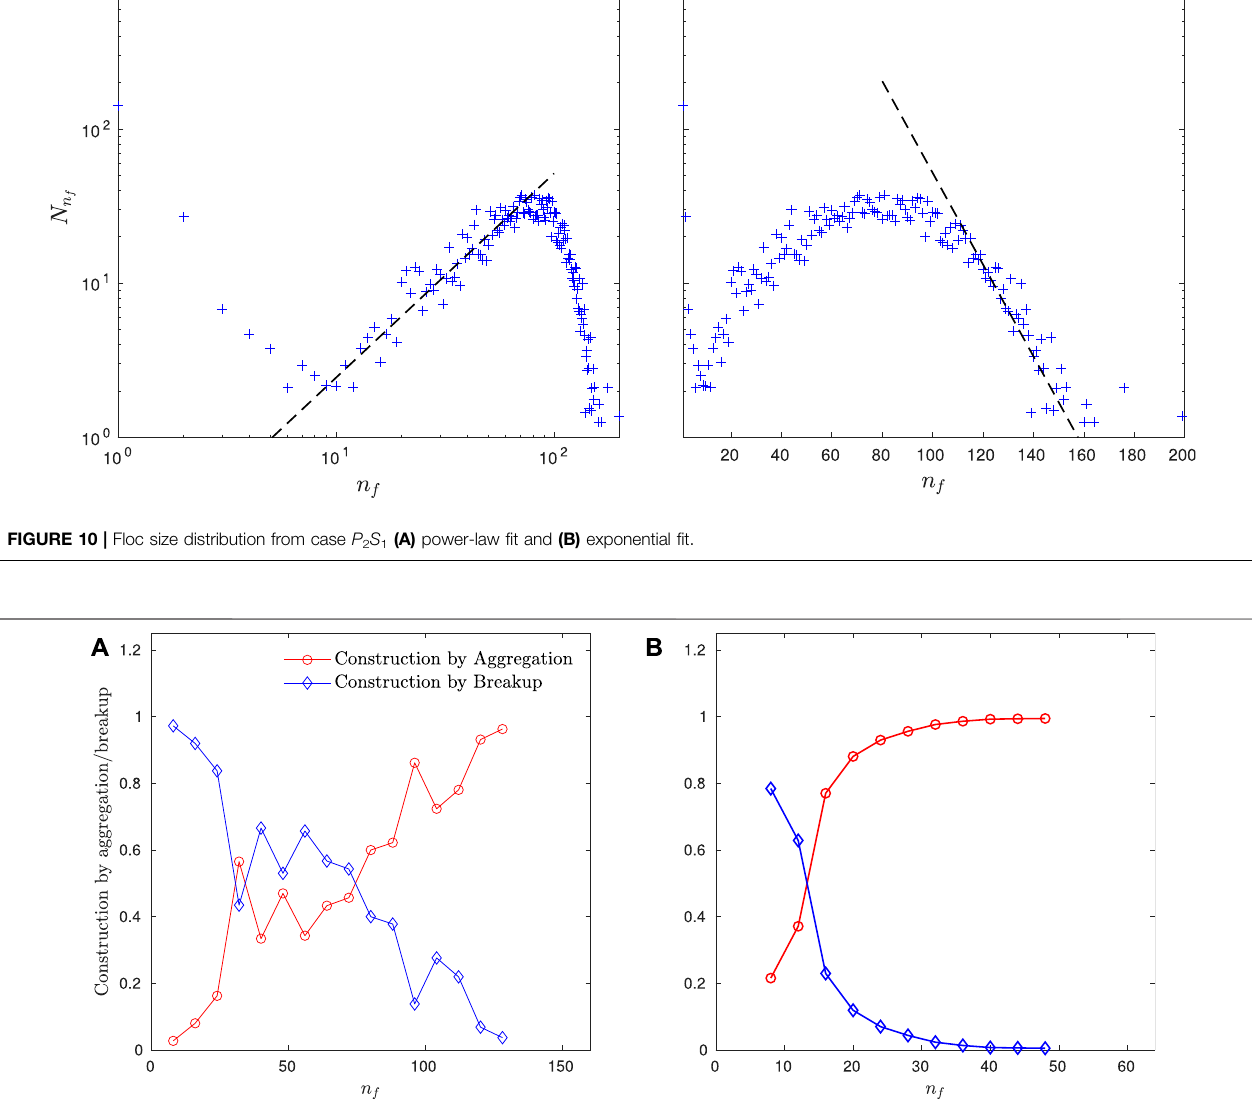
Frontiers in Earth Science |